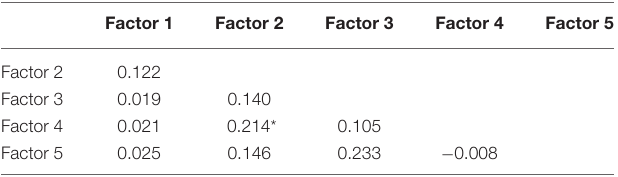
TABLE 3 | Study 1: Exploratory factor analysis inter-factor correlations for the five-factor solution.